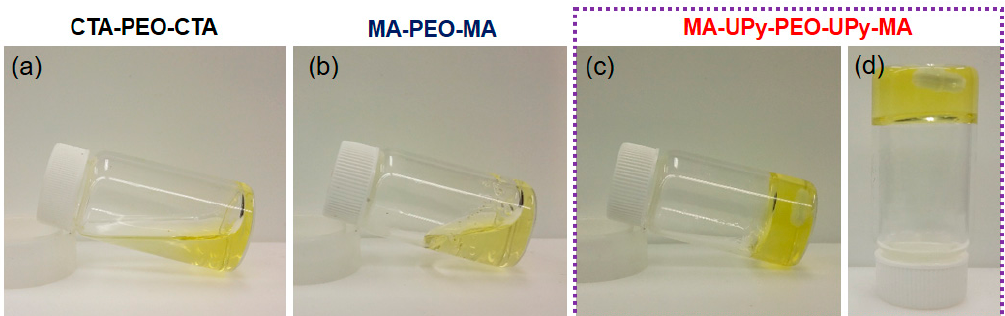
Figure 2. The gestation test of supramolecular hydrogel: ( a , b ) the solution of CTA-PEO-CTA and MA-PEO-MA is at a sol state at room temperature, while the solution of MA-UPy-PEO-UPy-MA can form a stable hydrogel ( c , d ).